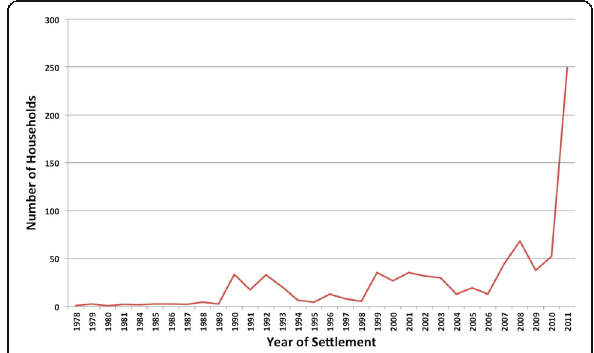
Figure 5 Number of households immigrating to the KGR 1978 to